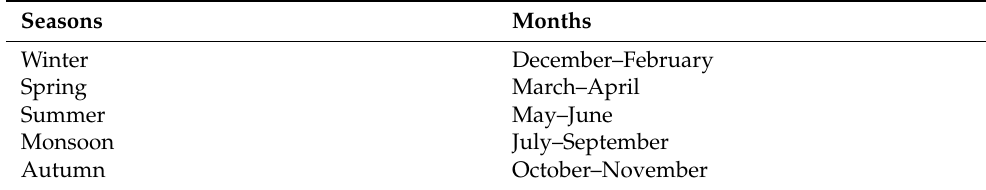
Table 2. Sampling time (seasons and months) February 2019 to November 2020.